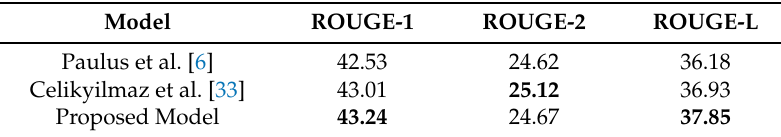
Table 5. Comparison of the proposed model with previous models trained with the NYT corpus.